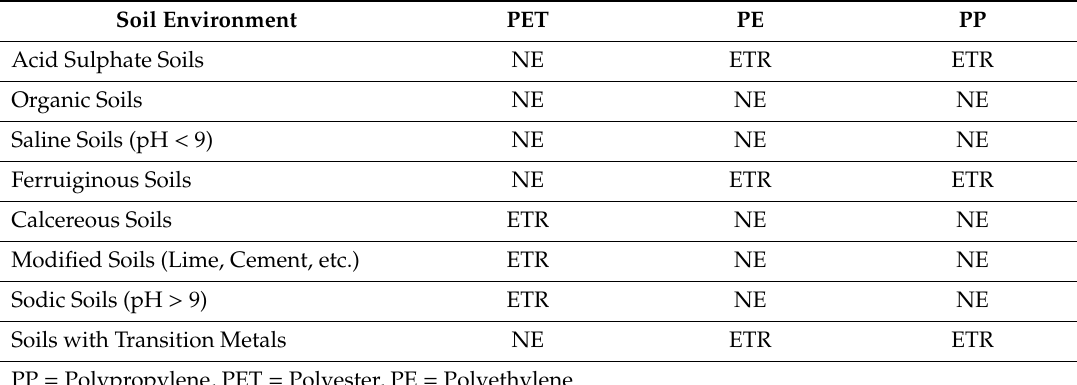
Table 1. Geosynthetic Resistance to Specific Soil Environments